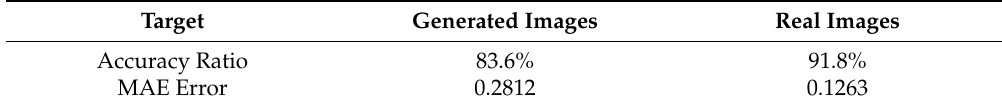
Table 1. Comparison Result of Age